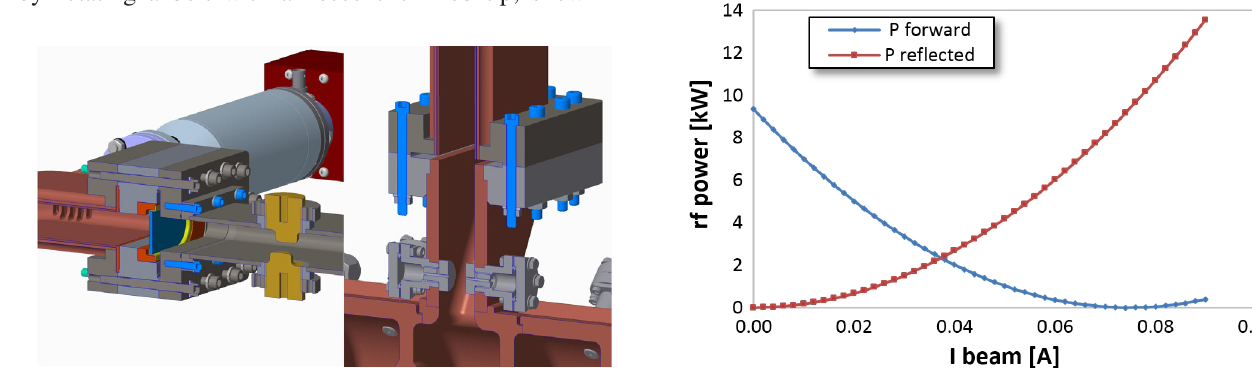
FIG. 8. A calculation of forward and reflected power at the 2.1 GHz cavity FPC versus the beam current at 250 kV cavity